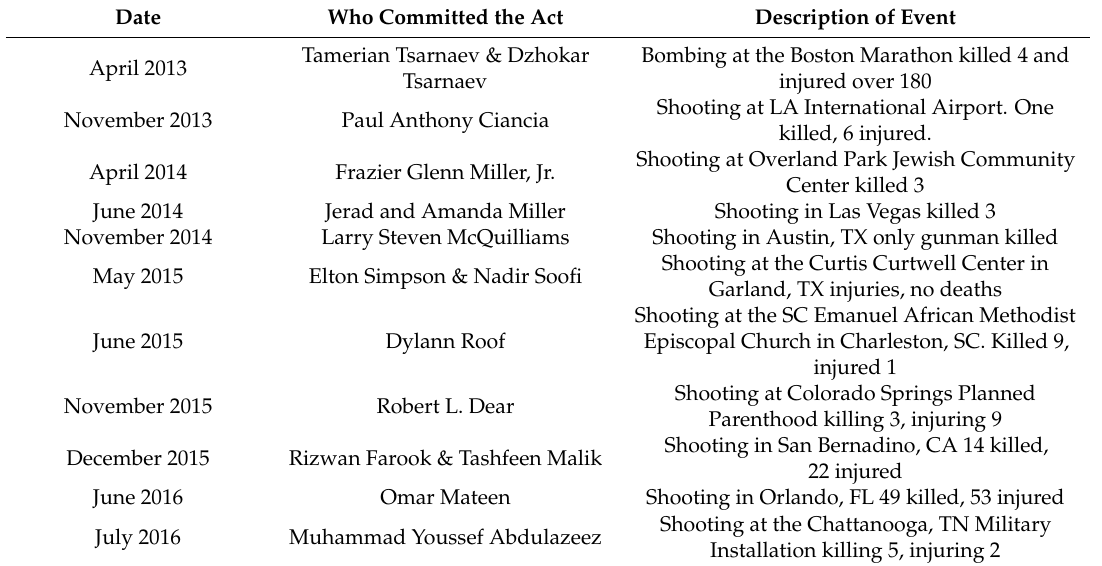
Table 1. Terrorist events in the U.S.